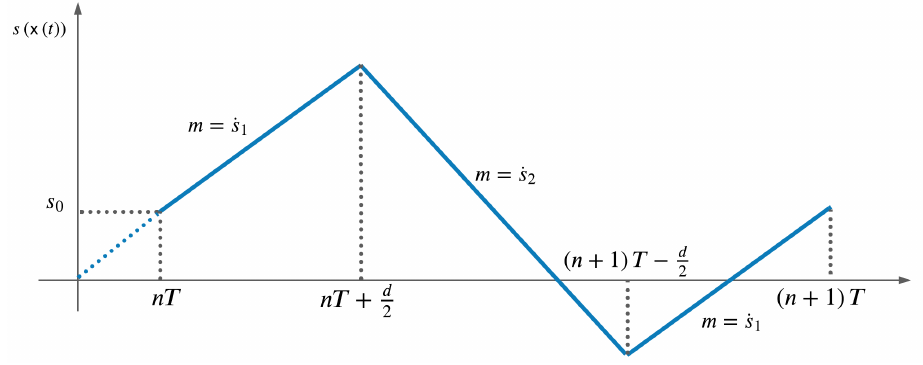
Figure 4. Piecewise linear approximation of the switching